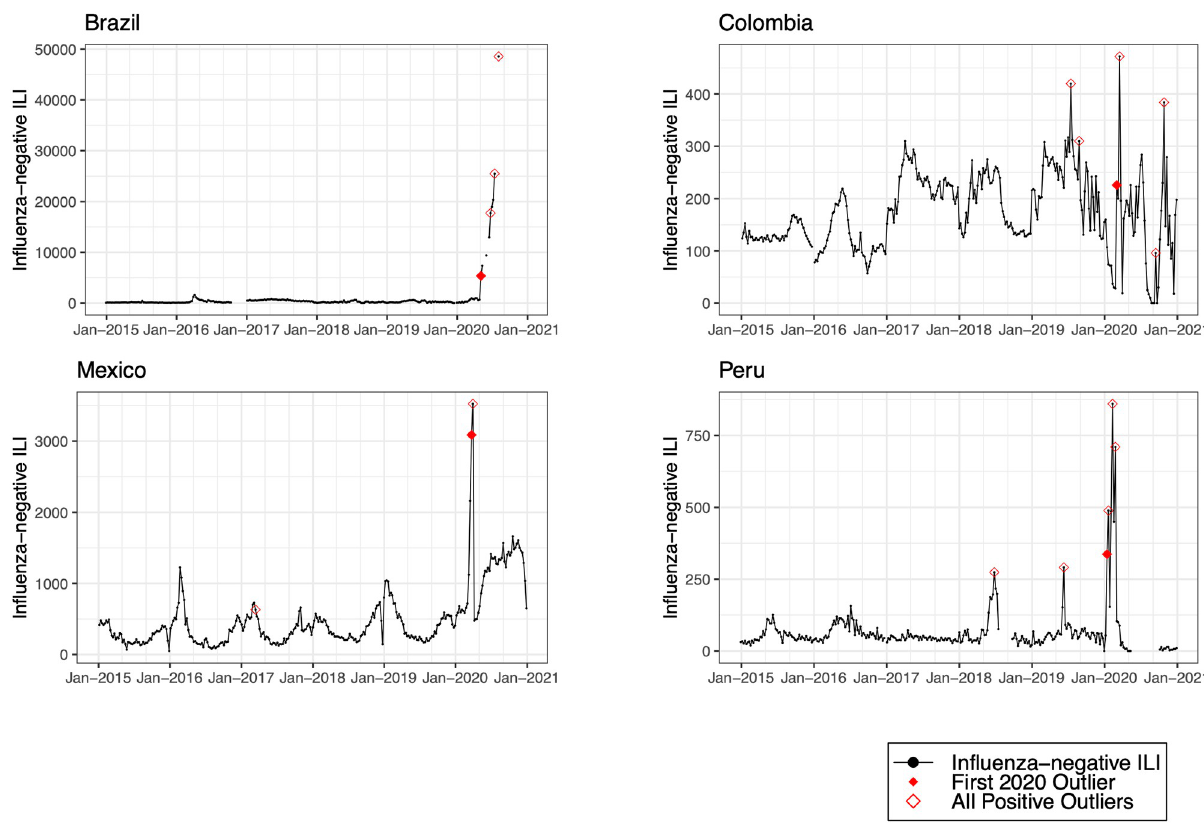
Fig 2. Observed trends in influenza-negative influenza-like illness (ILI) and detected outliers in upper-middle-income countries. Reported cases of influenza-negative ILI in each country between 2015 and 2020. Open red diamonds indicate all detected positive outliers, and filled red diamonds indicate the first outlier in